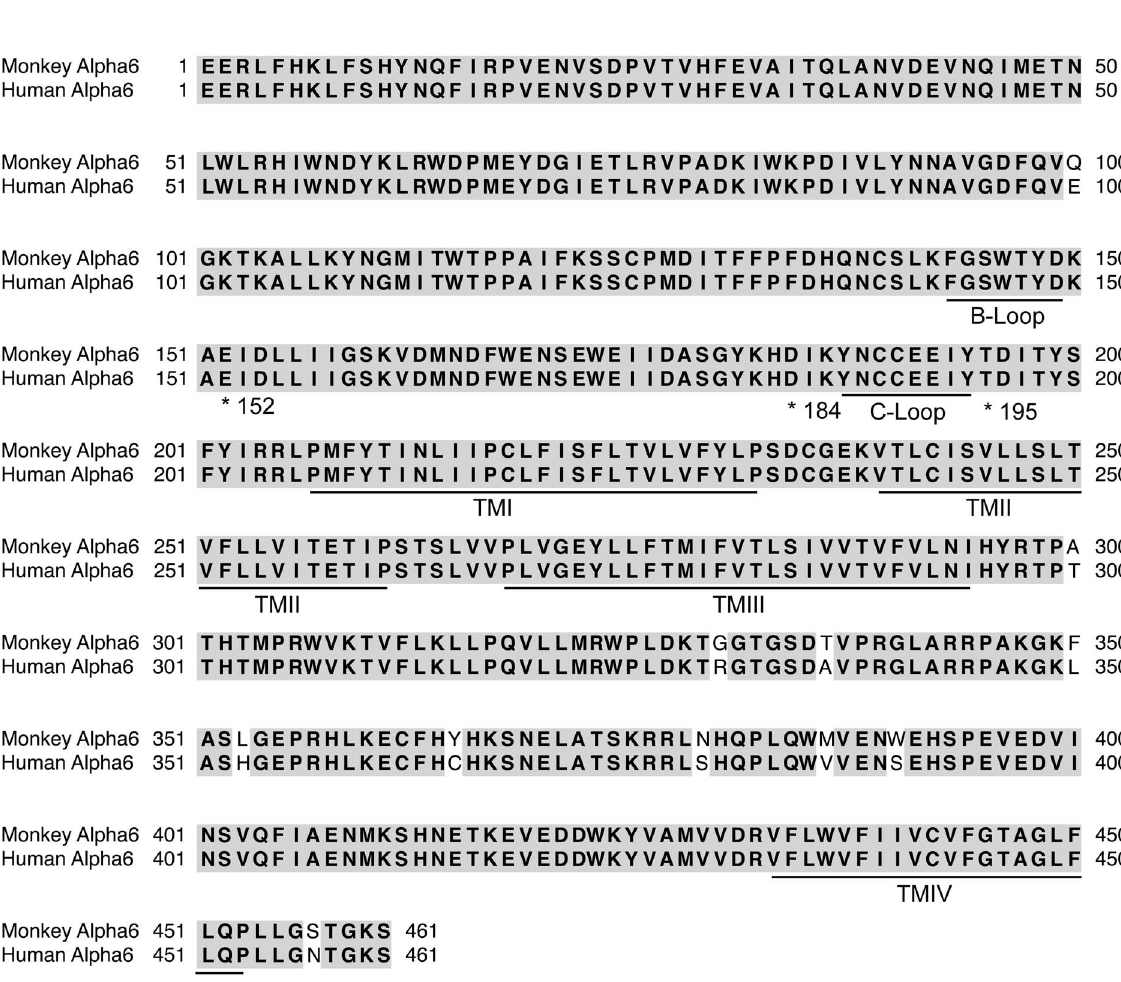
Figure 8. Sequence alignment of monkey and human a 6 nAChR subunits. A, Sequence alignment of monkey and human a 6 subunits identified a single residue in the extracellular ligand-binding domain at position 100 that differed between the two species. The asterisks identify residues that have previously shown to be important for a -Ctx binding [47,48,49]. Note that these residues are strictly conserved between the two species. TM indicates the transmembrane domains.